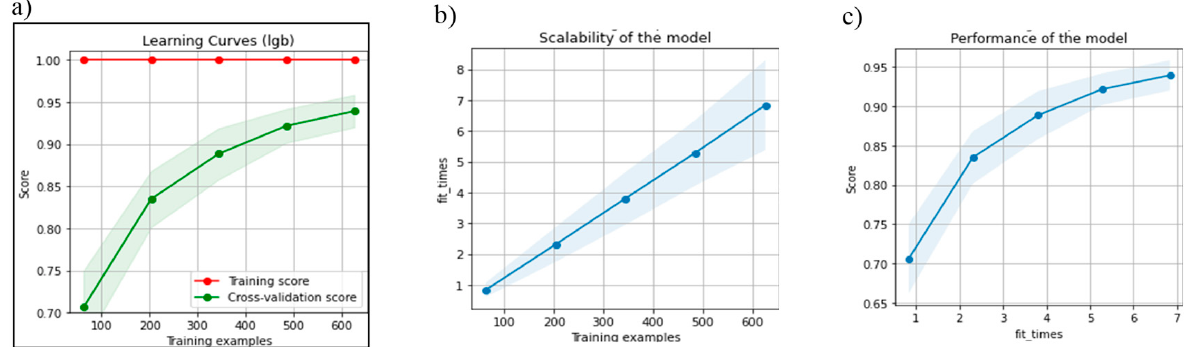
Figure 16. ( a ) Learning curves, ( b ) Scalability of the model, and ( c ) Performance of the model.